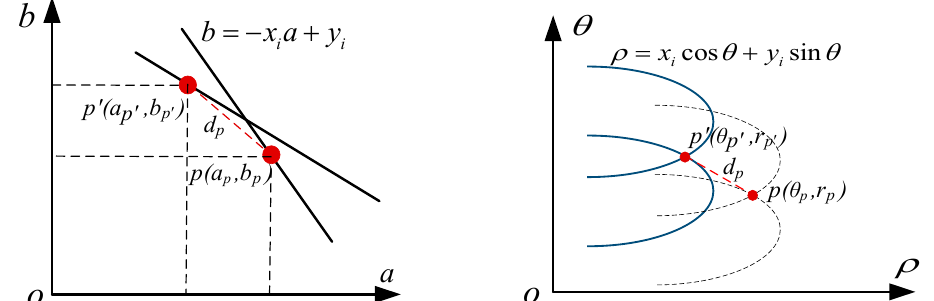
Figure 5. Schematic diagram of the linear distance representation in the different coordinate sys ‐ tems.